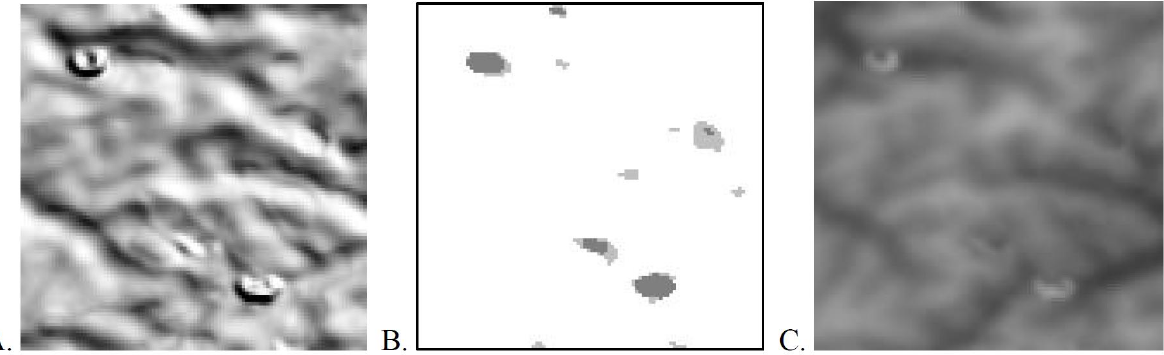
Figure 4. Example of “bump” artifacts; (A) shaded relief, (B) clear relation to the stack number boundaries, (C) appearance in ASTER GDEM image (originally appeared in [8]).